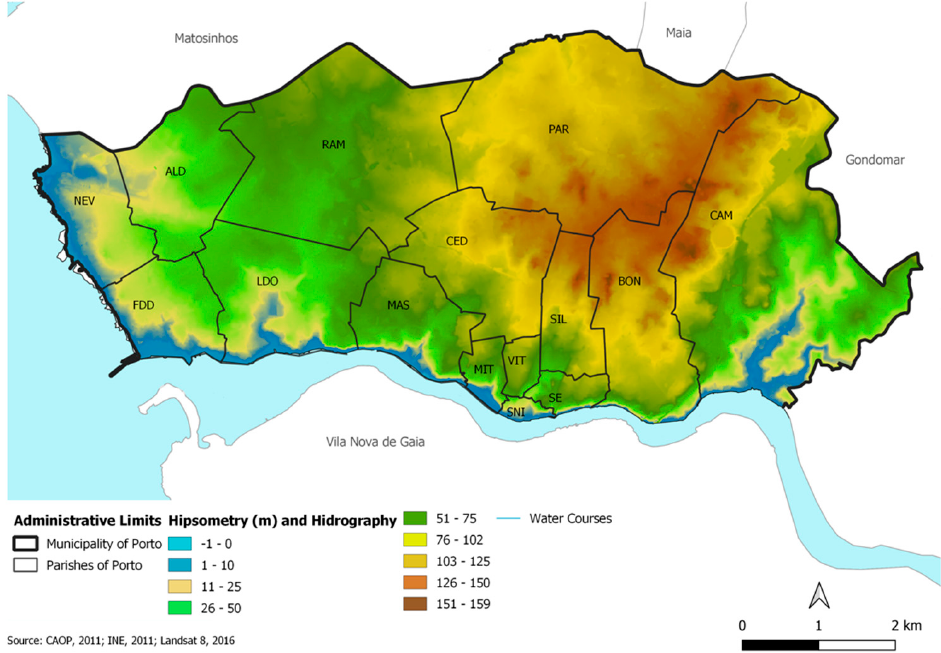
Figure 1. Natural factors determining the context of bioclimatic comfort: morphology and hydrographic network [31].